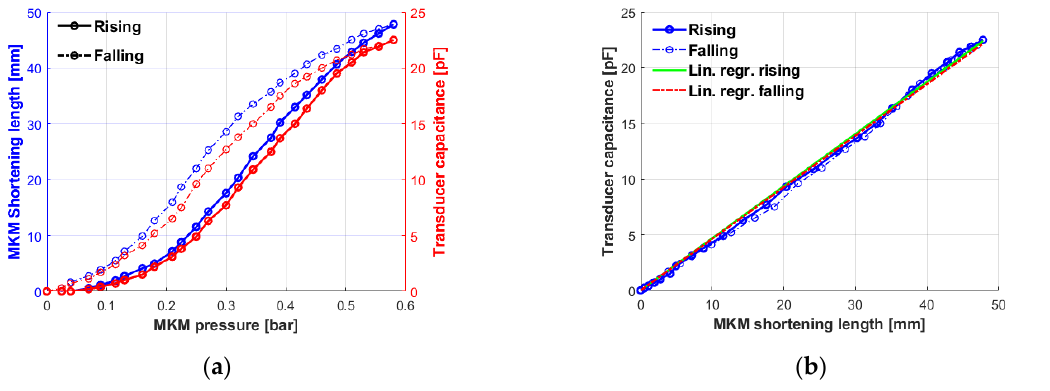
Figure 10. Experimental characterization of the proposed MKM. Panel ( a ): MKM shortening length and transducer capacitance as a function of the pressure; Panel ( b ): Correlation between the transducer capacitance and the MKM shortening length with the results of the linear fitting procedure.